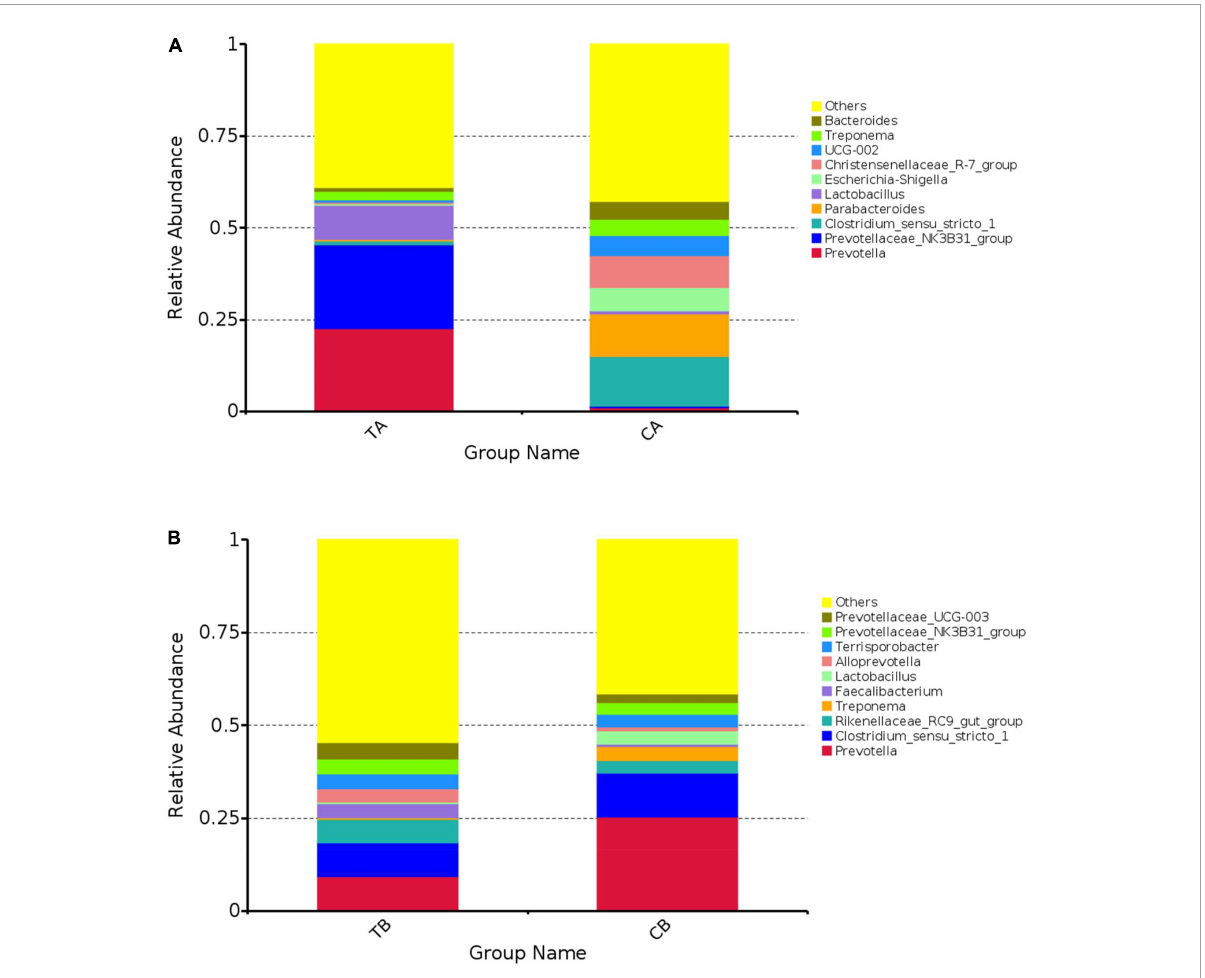
FIGURE5 The 10 most abundant bacteria of gut microbiota at genus level for intestinal microbiota of piglets weaned on day 14 of age (14W) and day 28 of age (28W) at different sampling timepoints [day 28 of age (A) ; day 70 of age (B) ]. The horizontal axis is the groups. The vertical axis represents the relative abundance. The “others” represents the sum of the relative abundance except the top 10 in the figure. CA group was defined as the sample from piglets in 28W group at the timepoint of day 28 of age. TA group was defined as the sample from piglets in 14W group at the timepoint of day 28 of age (A) . CB group was defined as the sample from piglets in 28W group at the timepoint of day 70 of age. TB group was defined as the sample from piglets in 14W group at the timepoint of day 70 of age (B)